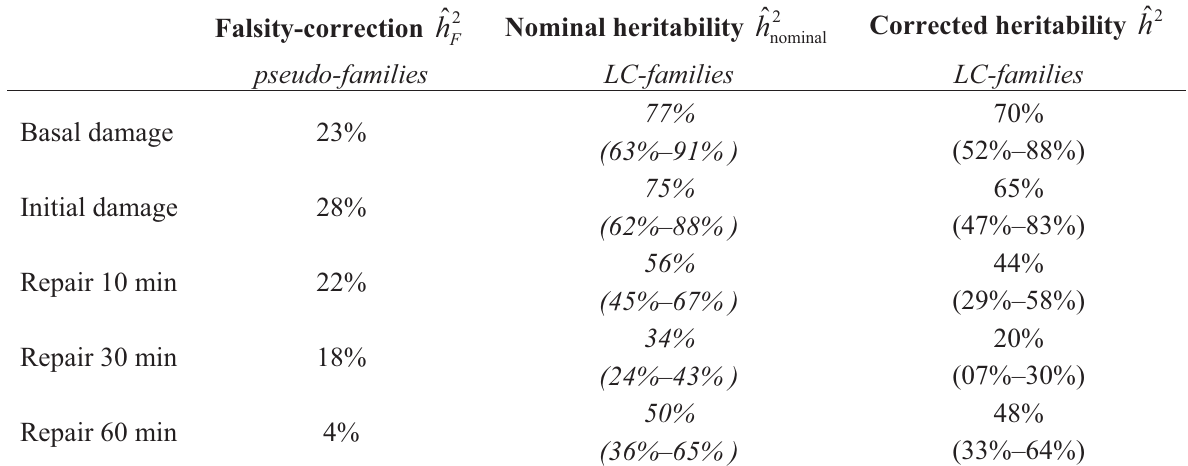
Table 2. Heritability of DNA damage and